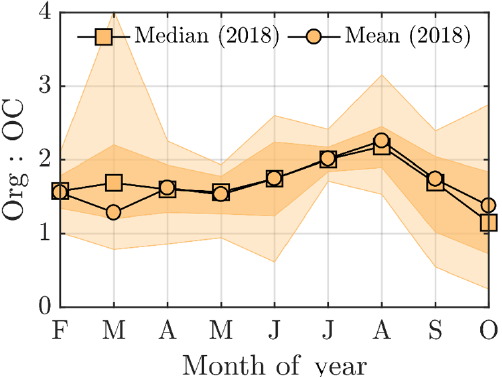
Figure A5. Organic carbon concentration (OC) vs. the organic aerosol concentration (Org) in 2018 at SMEAR II. The darker yellow shadings indicate the area between the 25th and 75th percentiles and the lighter yellow shadings indicate the area between the 10th and 90th percentiles.